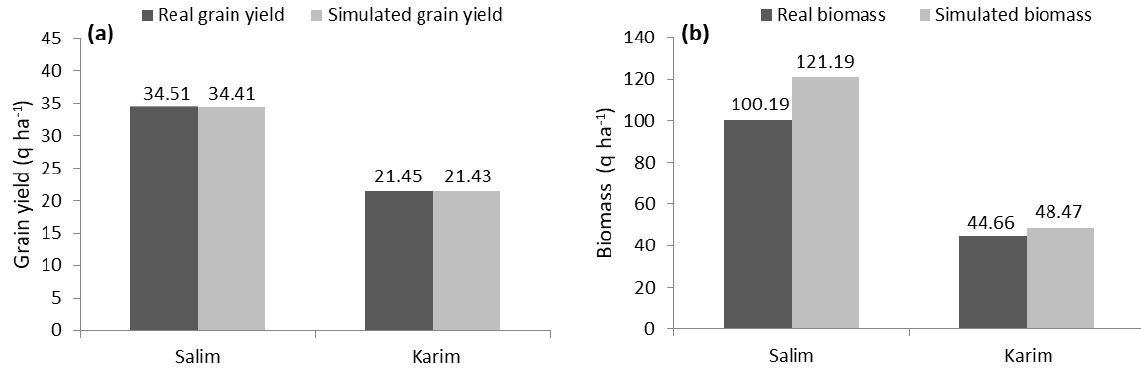
Figure 5. Real vs. simulated grain yield ( a ) and biomass ( b ) of ‘ Salim ’ and ‘ Karim ’ cultivars (2013/14 and 2014/15).